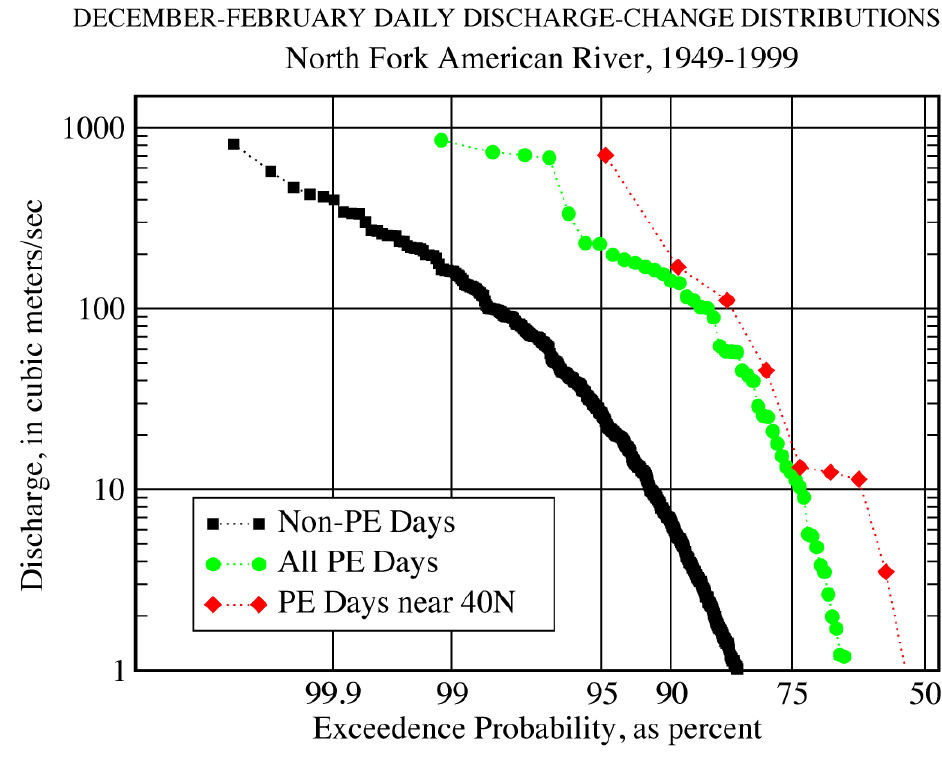
Figure 5. Exceedence probabilities for day-to-day changes in river discharge of the North Fork American River above North Fork Dam, above Sacramento, CA, under various December-February storm and precipitation